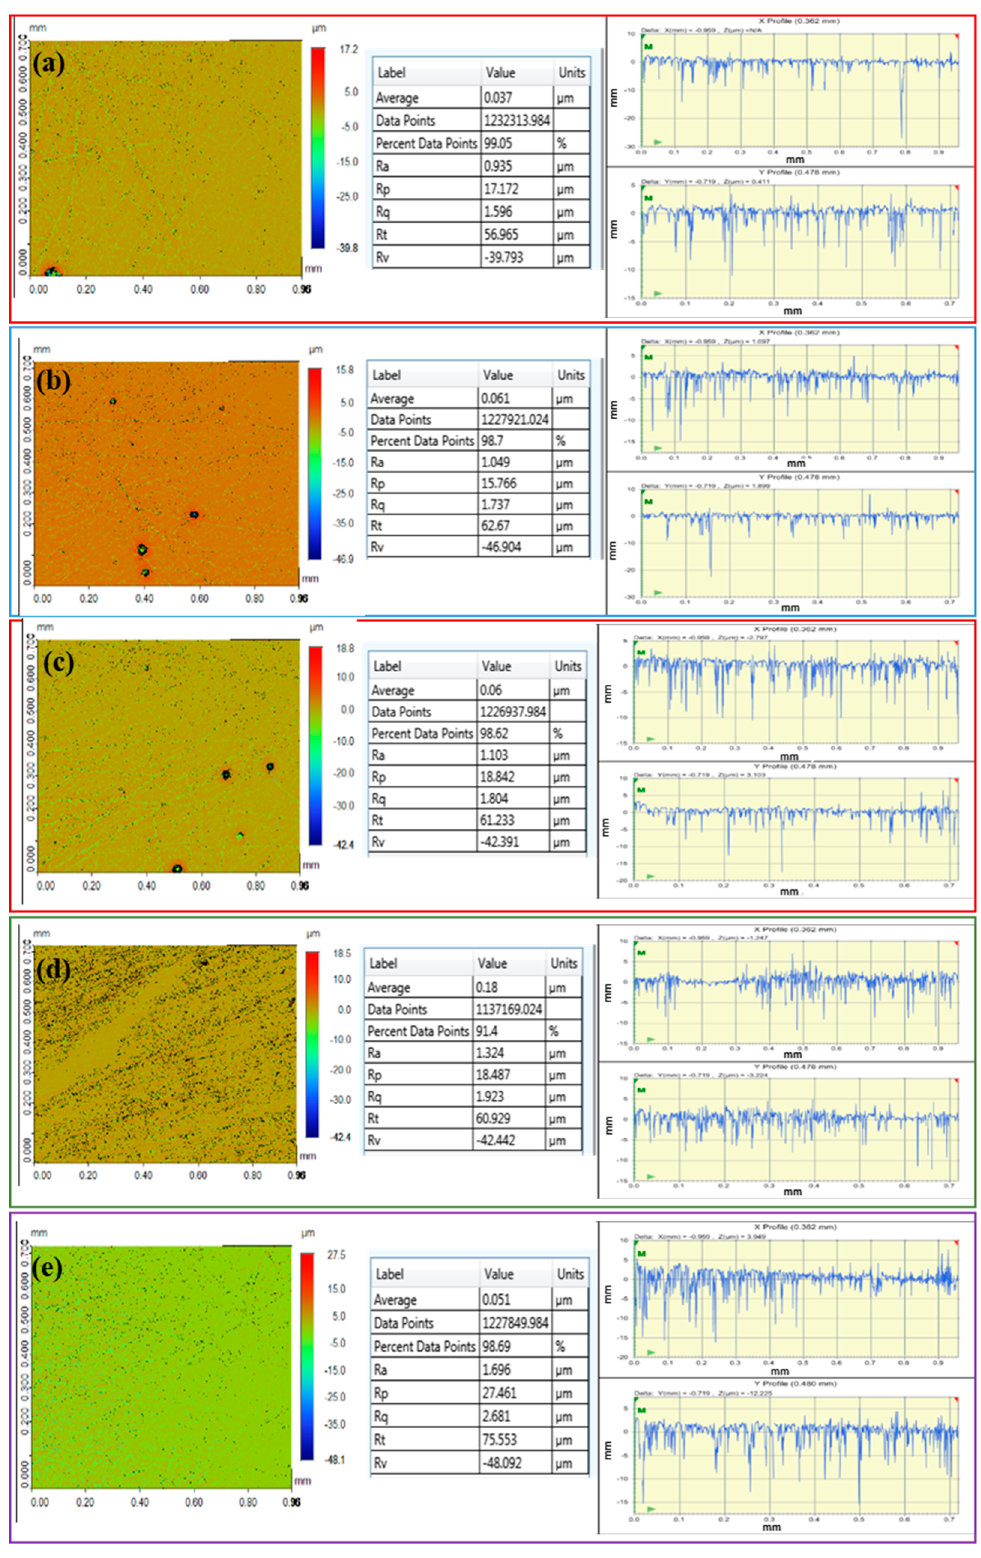
Figure 9. Topographic profilometry and surface roughness of the various resin composites with different geometrical topographies, ( a ) C0.0, ( b ) C0.5, ( c ) C1.0, ( d ) C2.0, ( e ) C4.0.